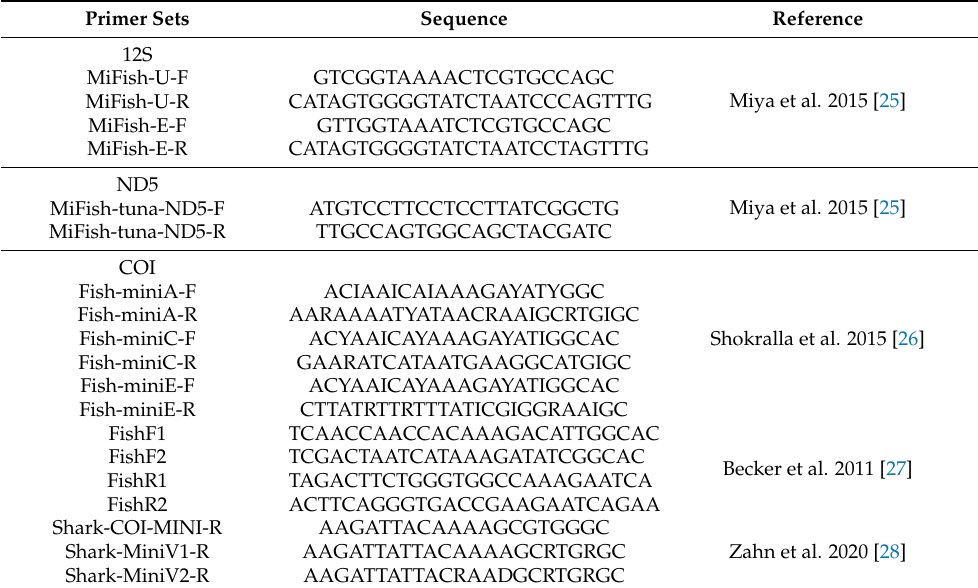
Table 1. A list of 19 universal primers validated for the amplification of mitochondrial genes fragments (12S, ND5,